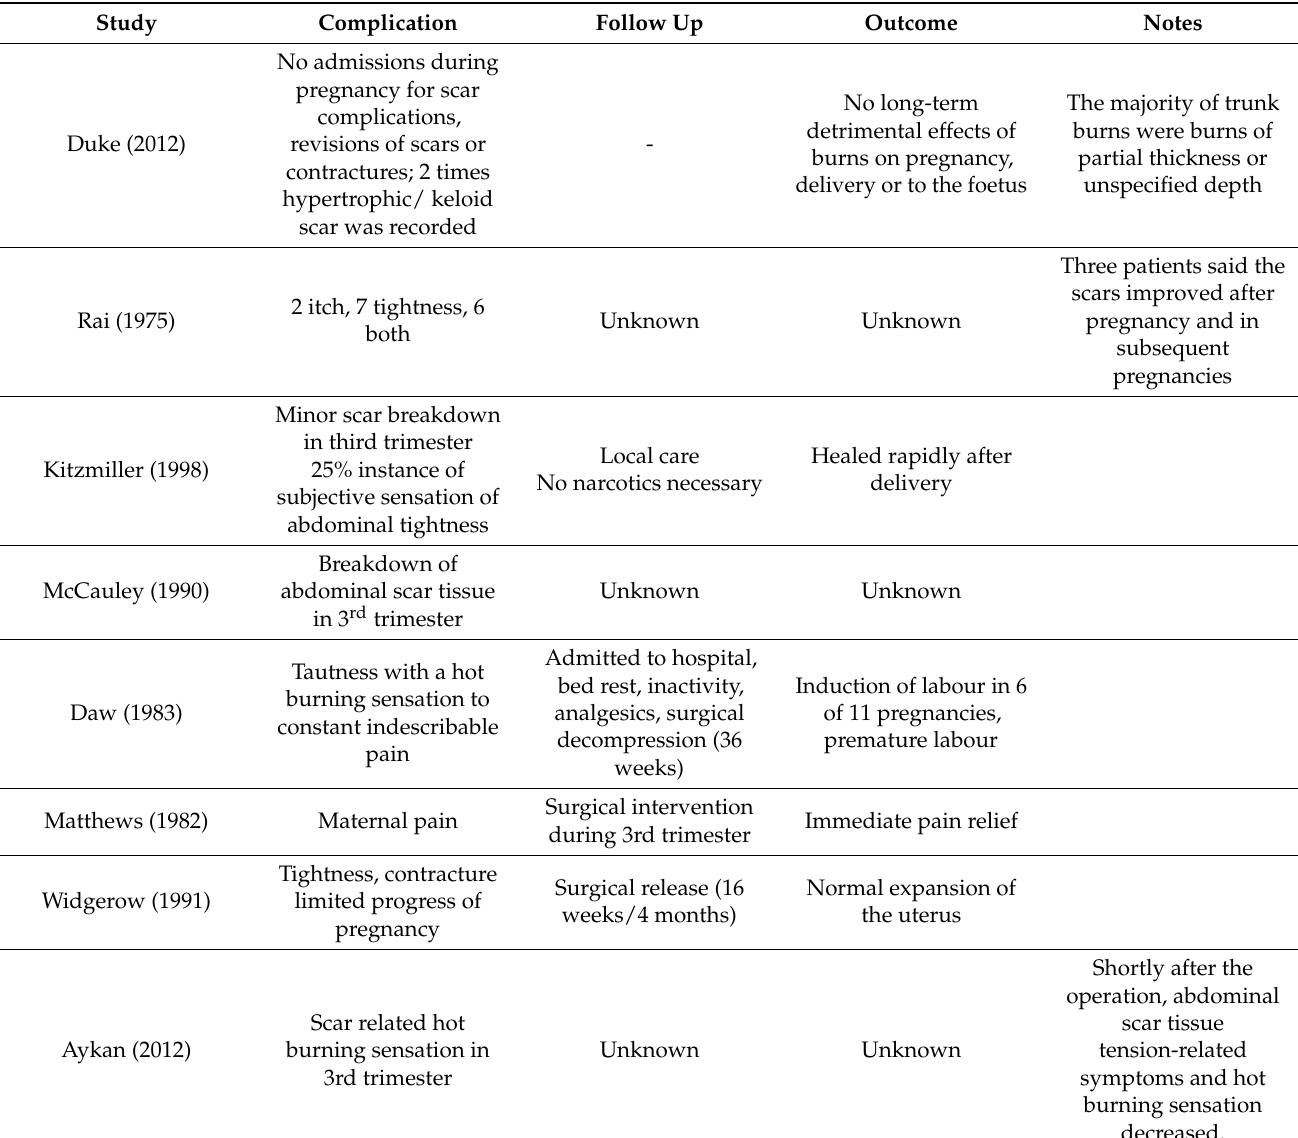
Table 3. Abdominal